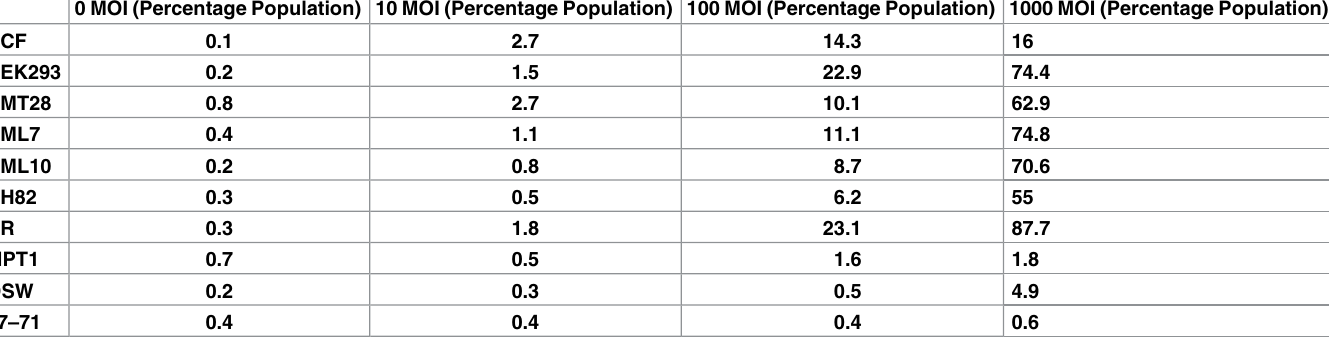
Table 2. Percent of Cells infected by